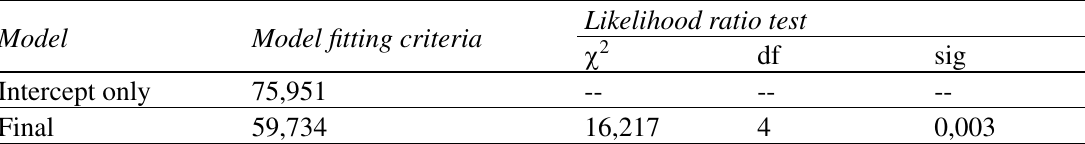
Tabel 5. Nilai kesesuaian model